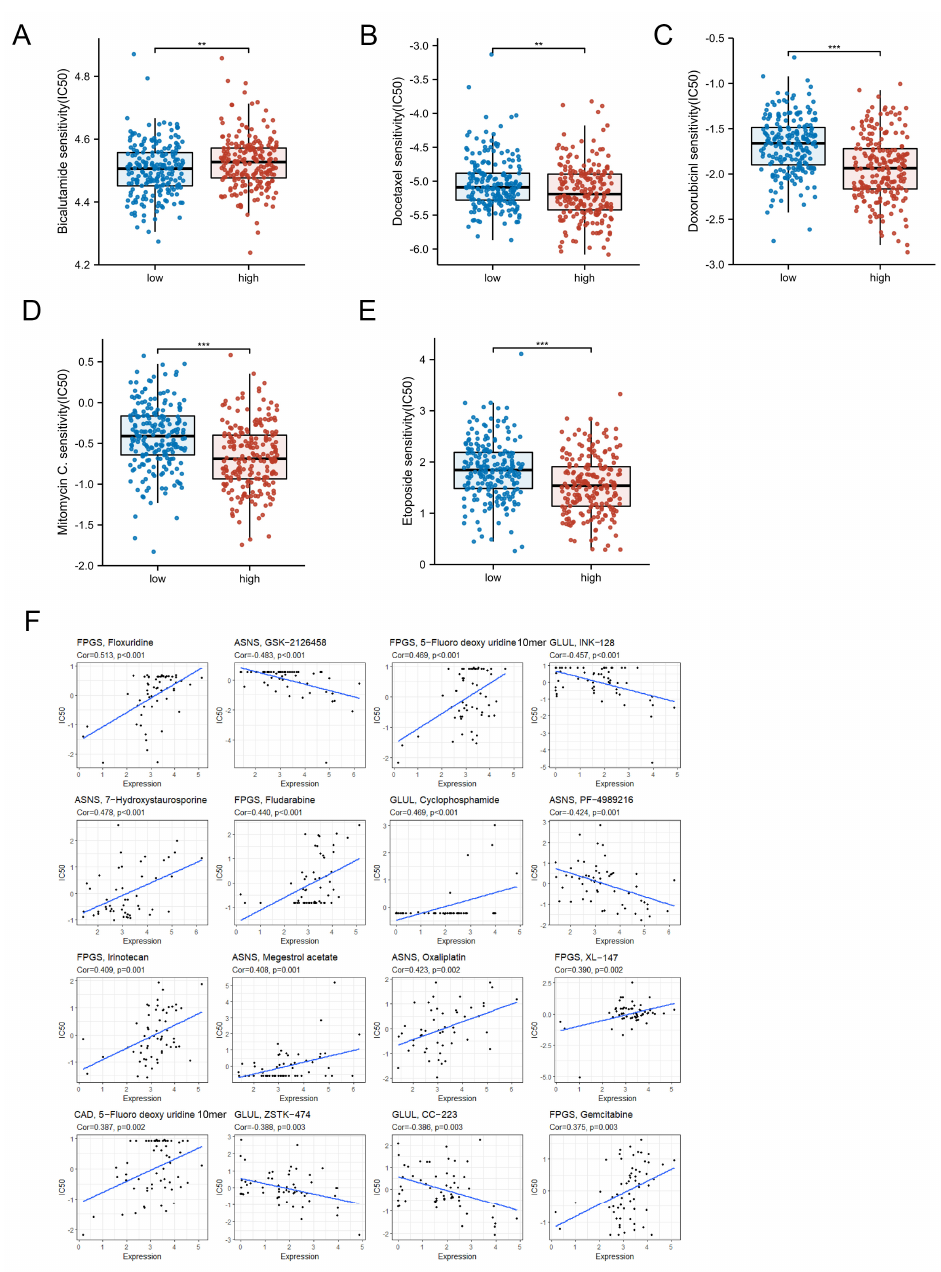
Figure 8. Drug sensitivity analysis in the different risk groups. ( A – E ) The IC50 of bicalutamide, docetaxel, doxorubicin, etoposide and mitomycin C difference between high-risk and low risk groups. ( F ) Anticancer sensitivity drug analysis of 5 genes. ** p < 0.01, *** p <